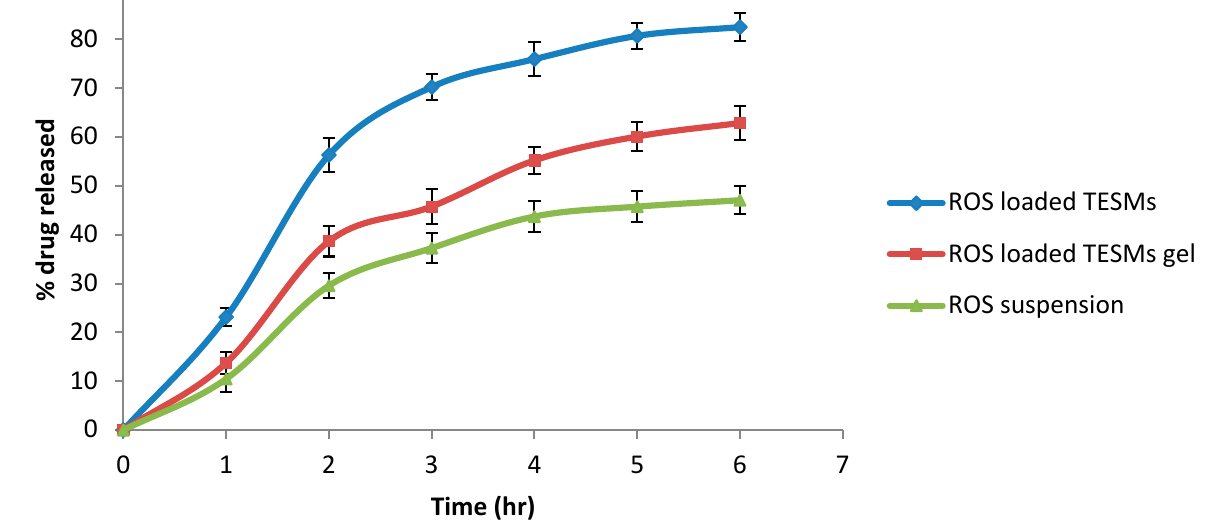
Figure 8. In vitro release profile of ROS from ROS-loaded TESMs compared with ROS-loaded TESMs gel and ROS suspension.